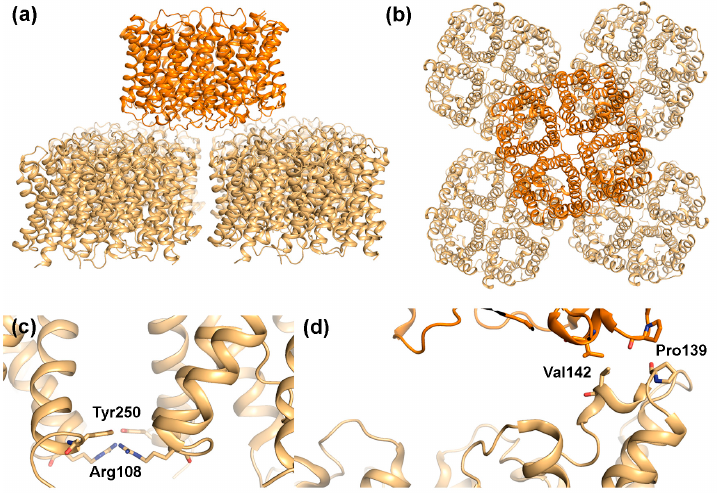
Figure 4. Structural features of AQP4 array formation. Double layered 2D-crystals formed by rat M23-AQP4 (PDB code 2D57) viewed: ( a ) parallel and ( b ) perpendicular to the membrane